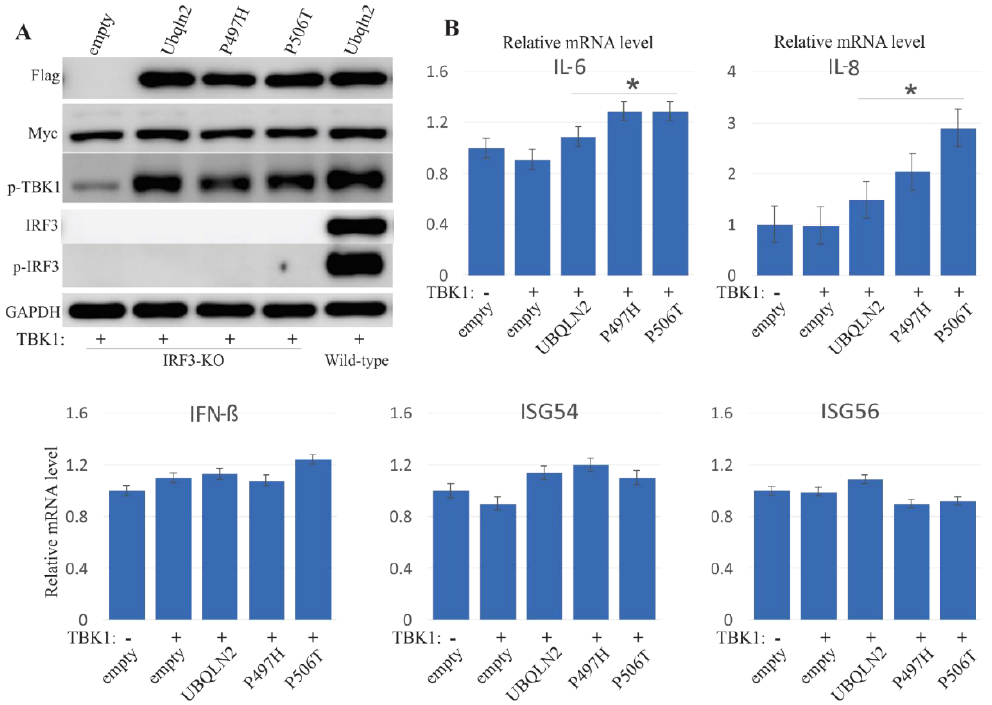
Figure 6. Loss of IRF3 abolishes the effect of UBQLN2 on IFN1 production. CRISPR–Cas9-mediated IRF3 knockout (KO) HEK-293T cells were transfected with Myc-tagged TBK1 and Flag-tagged wild-type or mutant UBQLN2. Harvested cells 24 h after transfection. ( A ) Immunoblot analysis revealed the expression levels of TBK1 when co-expressed UBQLN2 with TBK1 in IRF3-KO cells. ( B ) Quantitative PCR analysis revealed the relative levels of mRNA for IFN- β and related cytokines in IRF3-KO cells. The data are reported as the mean ± standard deviation (n = 3). * p <